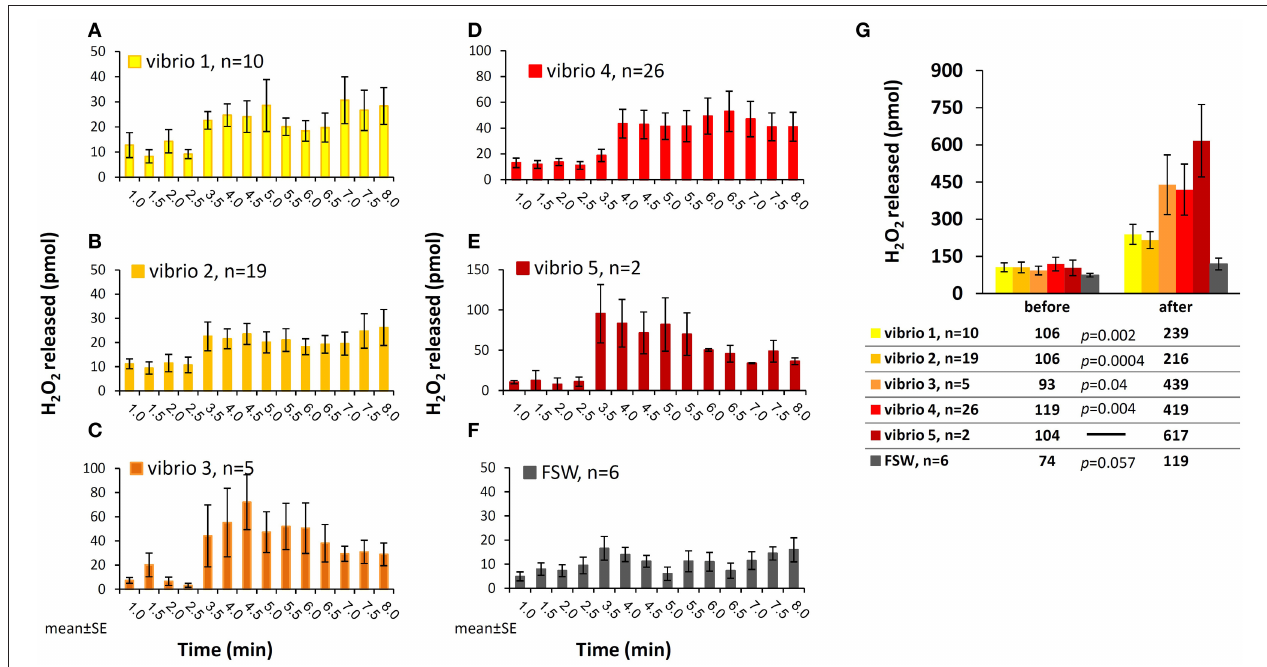
FIGURE 3 | Moles of H 2 O 2 released from S. pistillata following interaction with the five Vibrio isolates. (A–F) Calculated mols of H 2 O 2 released by the corals in discrete time intervals during interactions with the five Vibrio isolates (A–E) and seawater control (F) . The data set includes only experiments with positive H 2 O 2 accumulation after bacteria addition (i.e., Averaged after/before > 1, see Figure 2 ). (G) Total moles of H 2 O 2 released prior to and following interaction with bacteria, averaged for each of the Vibrio isolates tested. This calculation takes into account the different experimental durations before and after stimulation. The results of the paired t -test are shown below the